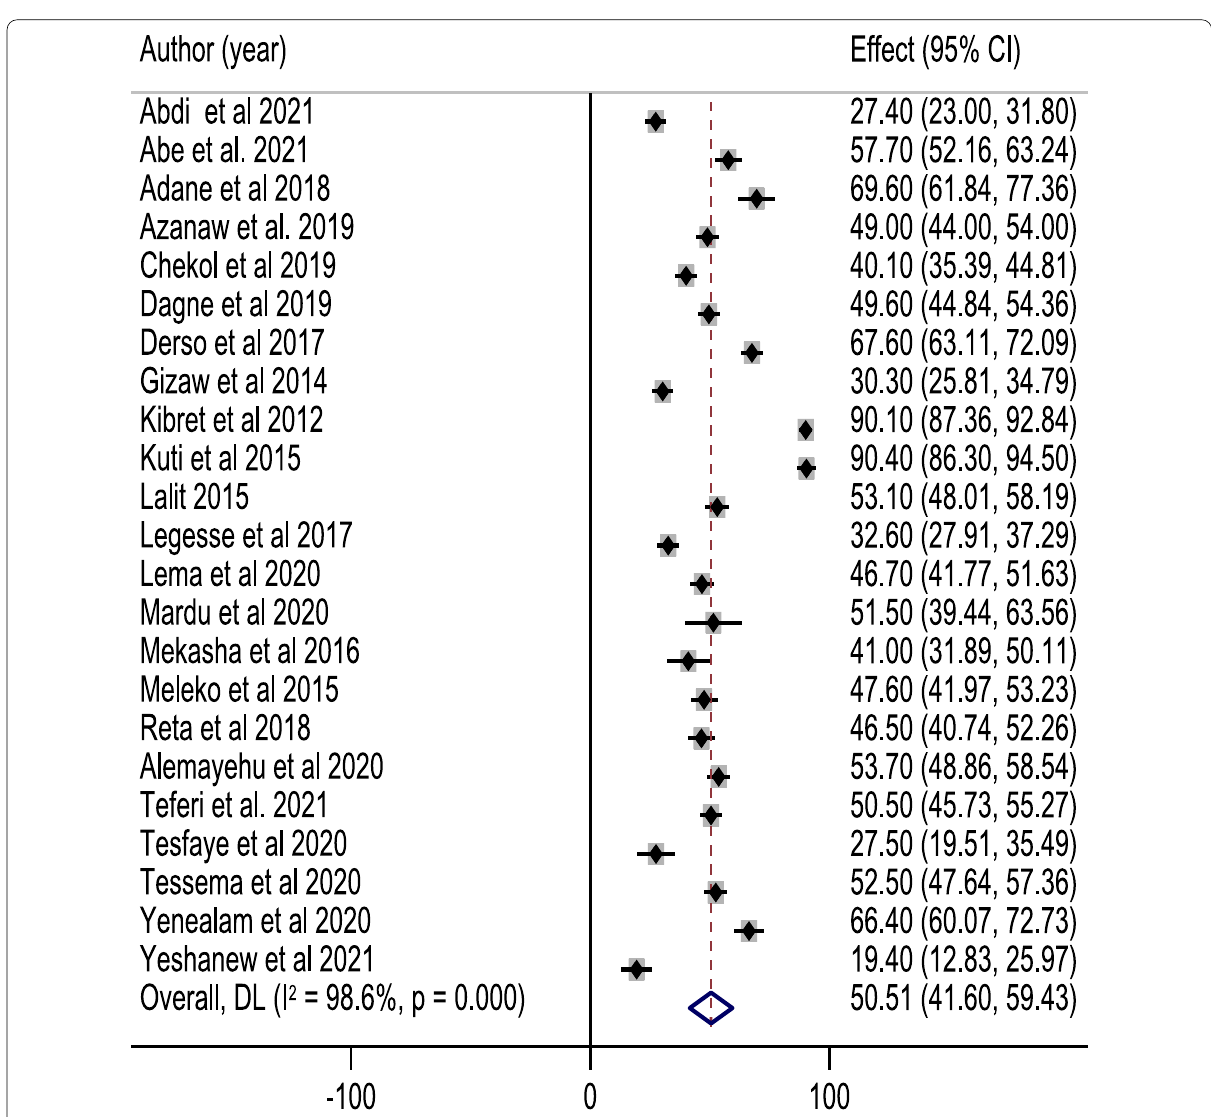
Fig. 2 Forest plot of pooled prevalence of good food hygiene practice among food handlers in Ethiopia